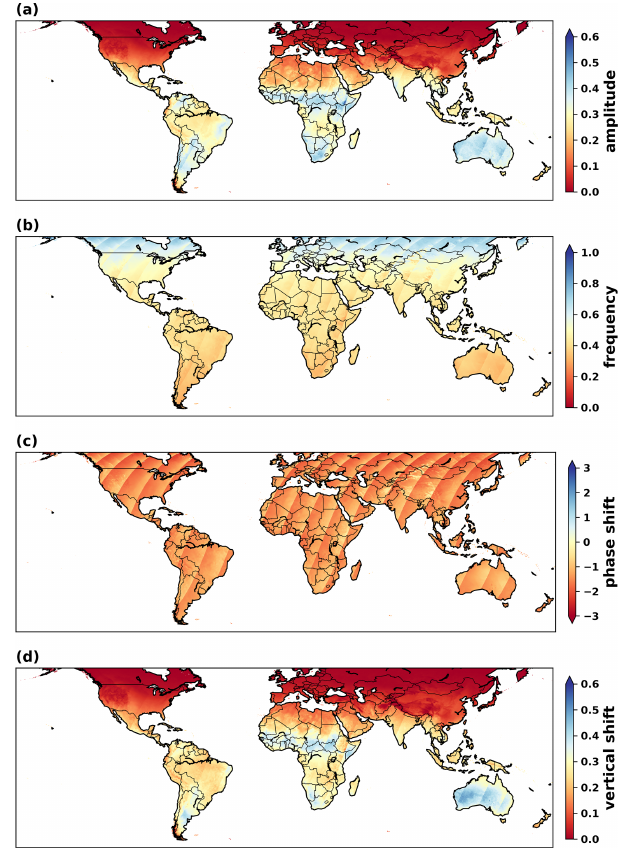
Figure 2. The sine function parameters estimated for January over the spatial domain of the stoPET model (global land surface lat- itudes between 55 ◦ N and 55 ◦ S). The parameters are described in Eq. (1), where (a) the amplitude (mmh − 1 ), (b) the frequency (h − 1 ), (c) the phase shift, (–) and (d) the vertical shift (mmh − 1 ) are